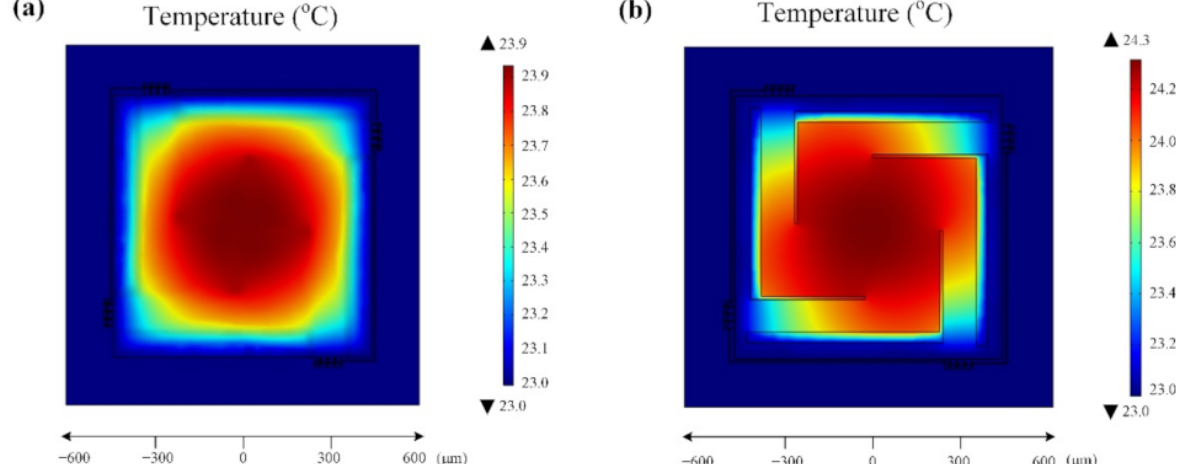
Figure 3. Simulated temperature distributions on the thermopiles. ( a ) The CM-based device, and ( b ) the MB-based